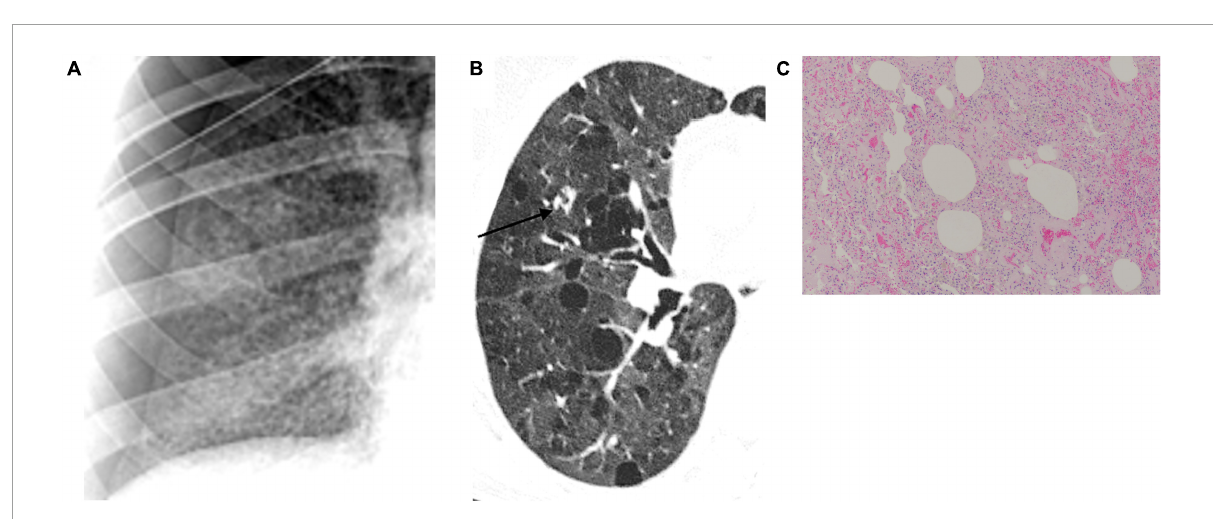
FIGURE6 Lung cystogenesis. Usually, the “holes” appear black on chest X-ray (A) and high-resolution computed tomography (B) and white on pathological specimens (C) . Courtesy of Dr. Luigi Panico, Azienda Ospedaliera dei colli, Naples,